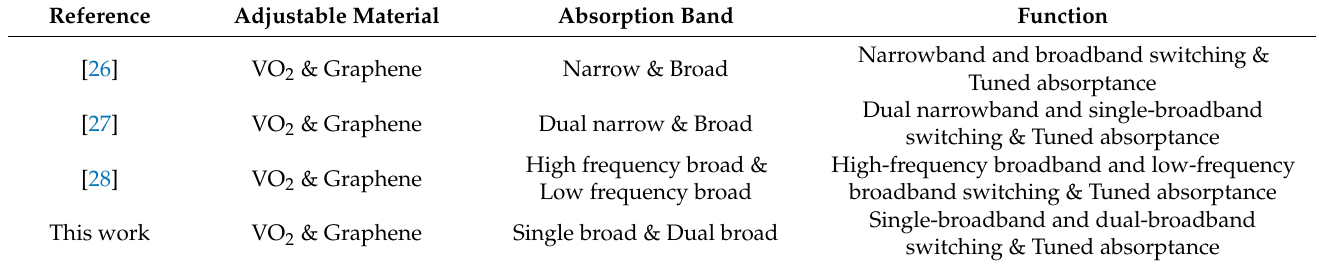
Table 1. The absorber in this paper is compared with other tunable absorbers in the THz band based on VO 2 and